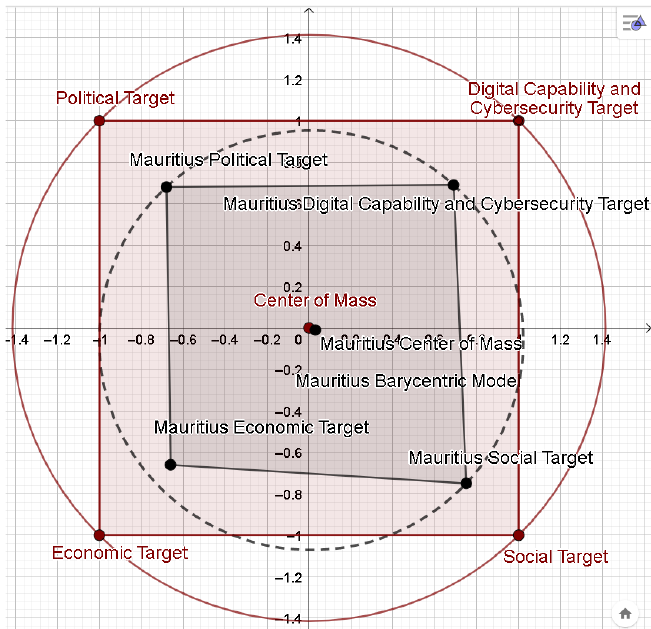
Figure 12. The four–pole barycentric model of balanced development of Mauritius. Source: Authors’ calculations